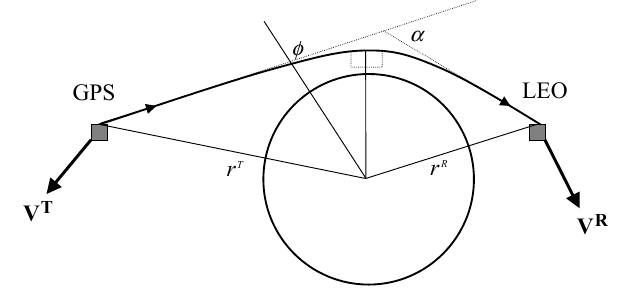
Fig. 1. The geometry of an RO measurement with a receiver on board a LEO